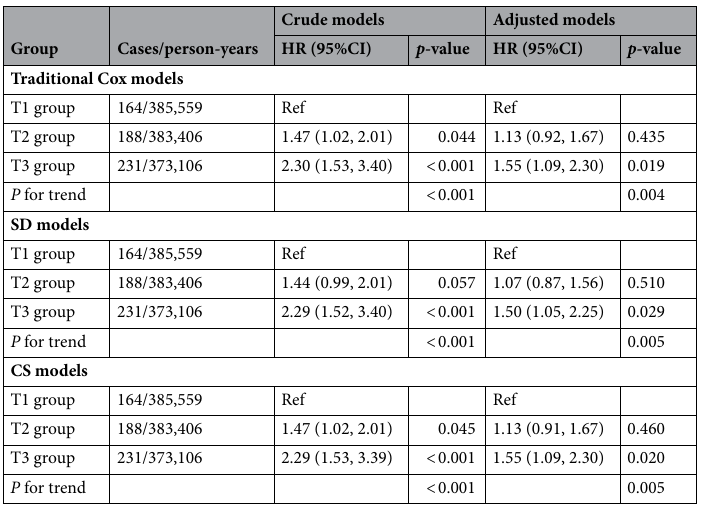
Table 2. Hazard ratios (HRs) for the association between SUA and the risk of CRC. Models were adjusted for age (every 10 years), sex, family income, educational background, marital status, BMI, TG, TC, TBIL, ALT, CRP, smoking status, drinking status, physical activity, sedentary lifestyle, tea consumption, high-fat diet, diabetes, hypertension, chronic kidney disease, and family history of cancer. SD models: the sub-distribution hazard function models. CS models: the cause-specific hazards models.